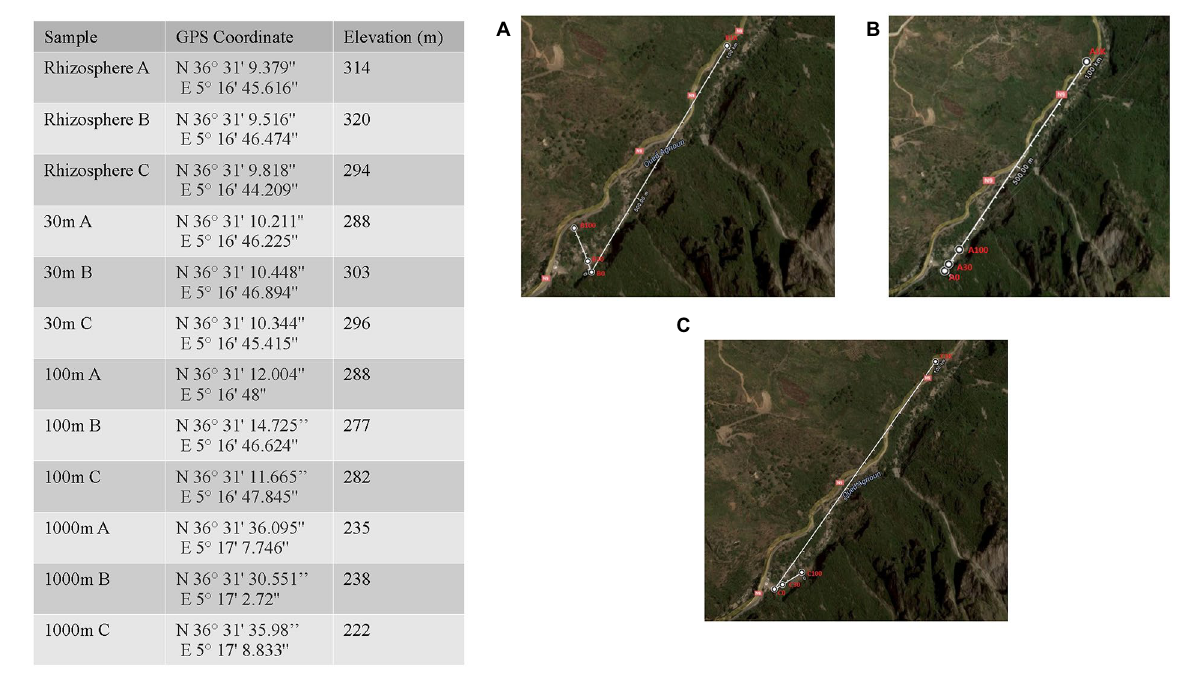
FIGURE 1 Location and geographic information for Algerian phytomicrobiome, soil, rhizosphere samples used in this study. Map insets A–C correspond to the three Coriaria myrtifolia plant